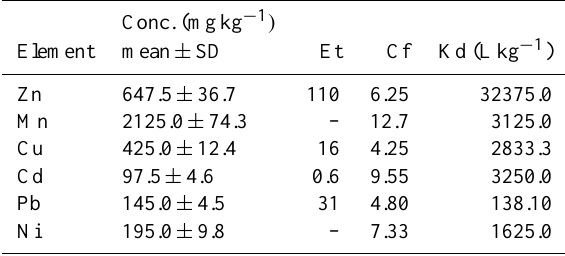
Table 4. Average heavy metal concentrations, contaminant factor, and distribution coefficients (Kd) in sediments of drain no. 5 com- pared with toxicological reference values (US EPA,